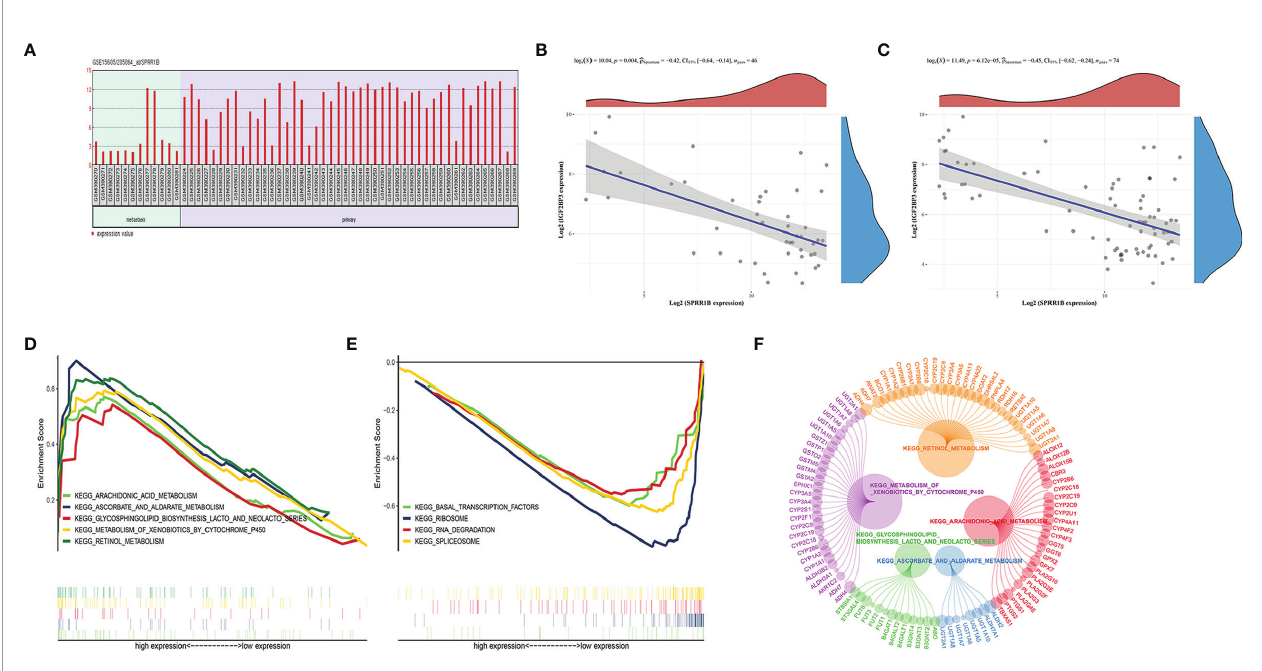
FIGURE 9 | (A) Expression of SPRR1B in carcinoma in situ and metastatic carcinoma in the GSE15605 dataset; (B, C) Correlation between expression of SPRR1B and IGF2BP3 in carcinoma in situ and metastatic carcinoma; (D, E) SPRR1b GSEA enrichment score; (F) Upregulating the core genotype of each pathway (the circle of the gene indicates the contribution to the pathway, and the larger the circle indicates the greater the contribution of the